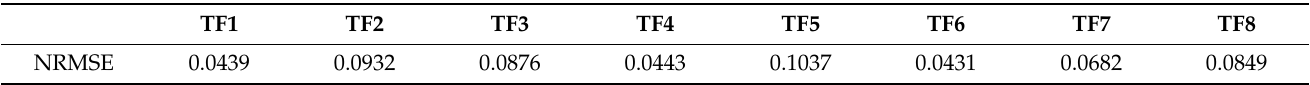
Table 11. NRMSE comparing the accumulated lactate output values of the forecast model using multiple datasets by applying DARX transfer function models on the averaged dataset using the goodnessOfFit function in MATLAB. The NRMSE closer to zero represents the better fit.